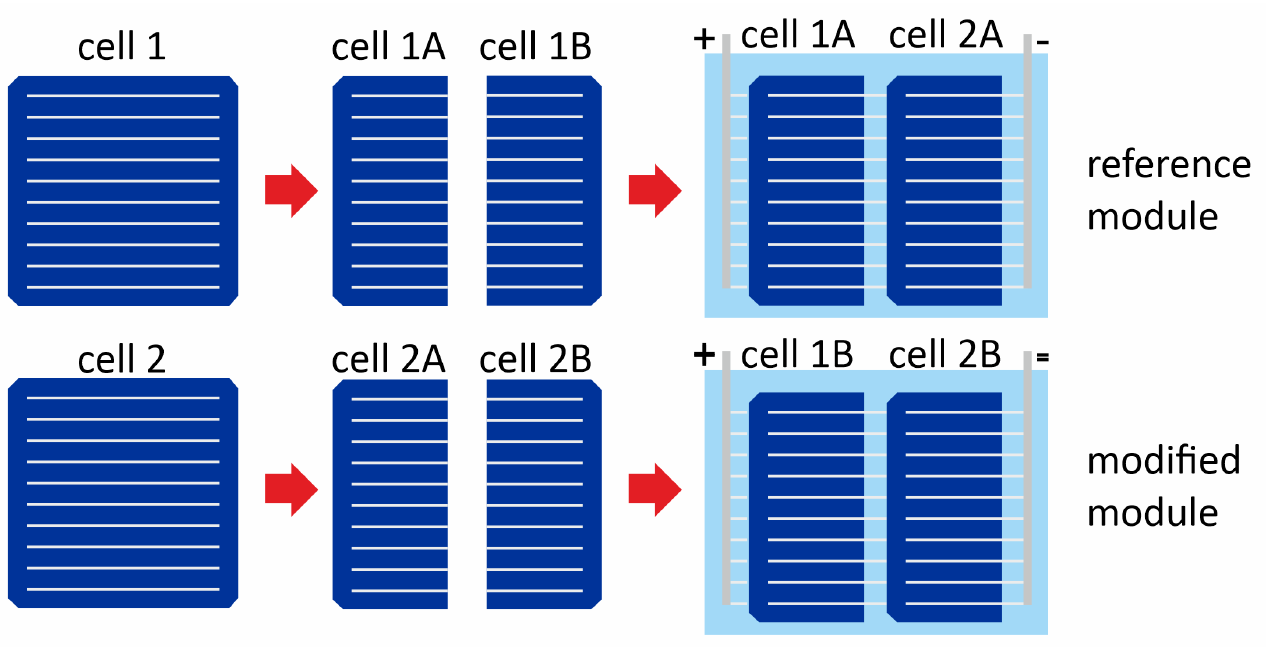
Figure 14. The self-compensating cell arrangement in minimodules for direct electrical comparison.